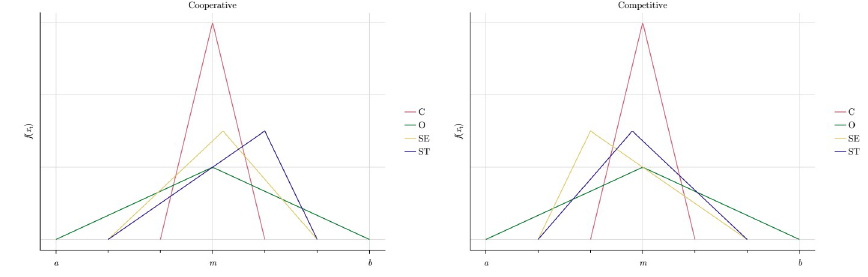
Fig 7. Cooperative vs. competitive reward